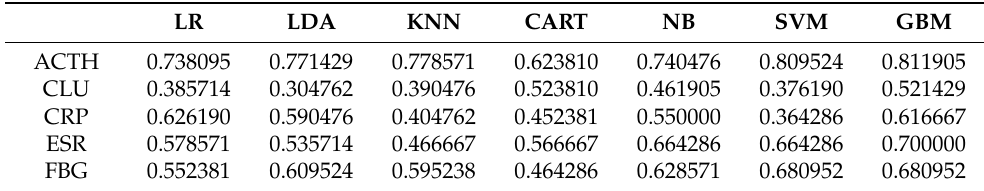
Table 11. Results of the analysis of databases with 7 machine learning algorithms, part of